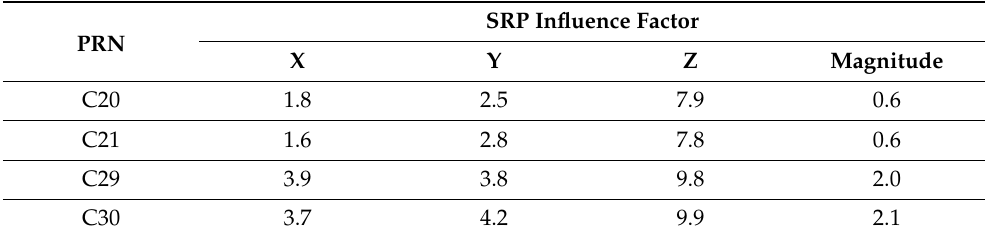
Table 10 reveals how SRP errors affect orbit accuracy in the R, T, and N directions.